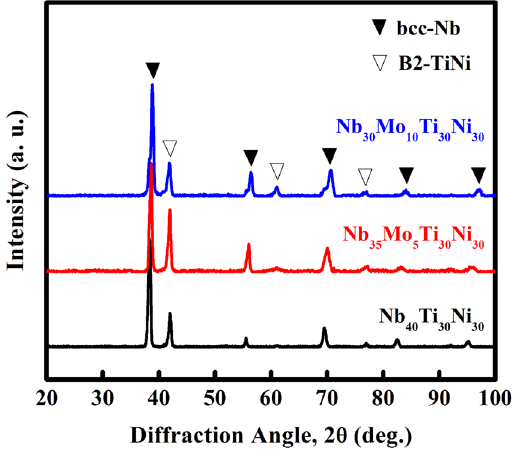
Figure 1. XRD patterns of as-cast Nb 40 Ti 30 Ni 30 , Nb 35 Mo 5 Ti 30 Ni 30 and Nb 30 Mo 10 Ti 30 Ni 30